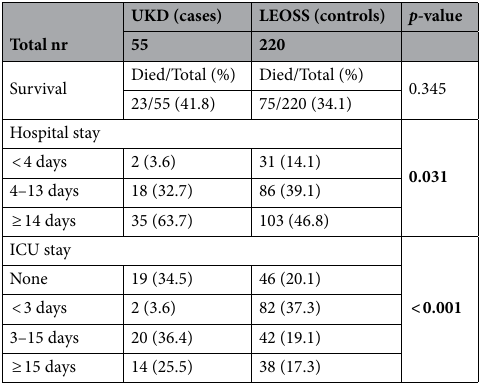
Table 6. Outcome comparison in the UKD-LEOSS matched pairs. *For 11 patients in the LEOSS controls cohort, data regarding ICU stay was not available. They were not included in analysis. Significant values are in